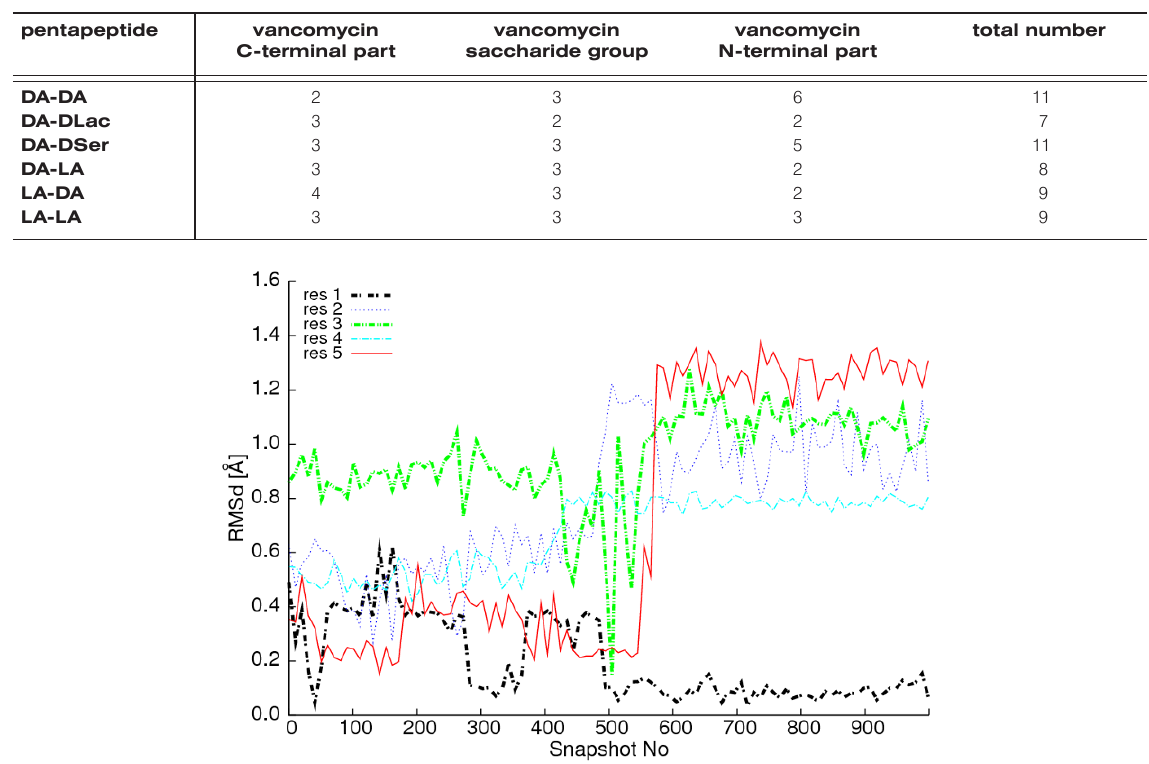
Table 1. Number of identified polar interactions per vancomycin part. pentapeptide